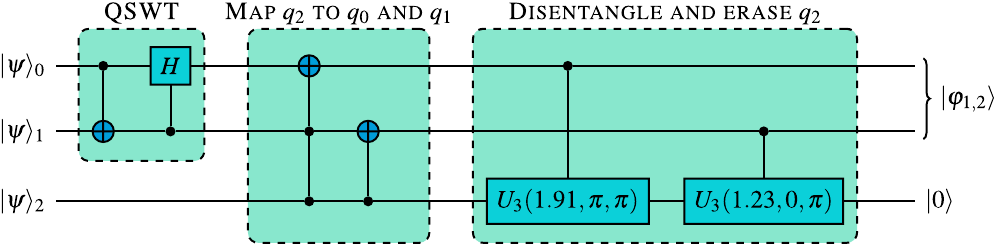
Figure 1. Basic circuit for compression of three qubits into two after a series of optimization comparing to the original results presented in 44 . QSWT stands for Quantum Schur–Weyl Transform, for details see 45 . Before execution on a real quantum processor it needs to be transpiled, i.e. compiled into basis